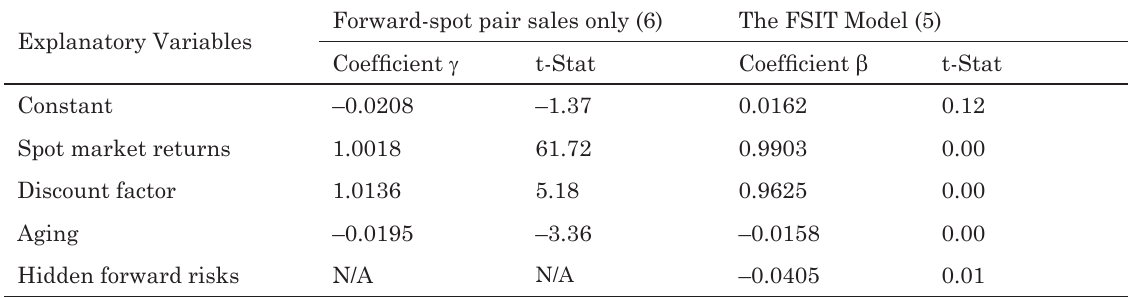
table 3. comparison between forward-spot pair sales and improved fsIt model Explanatory